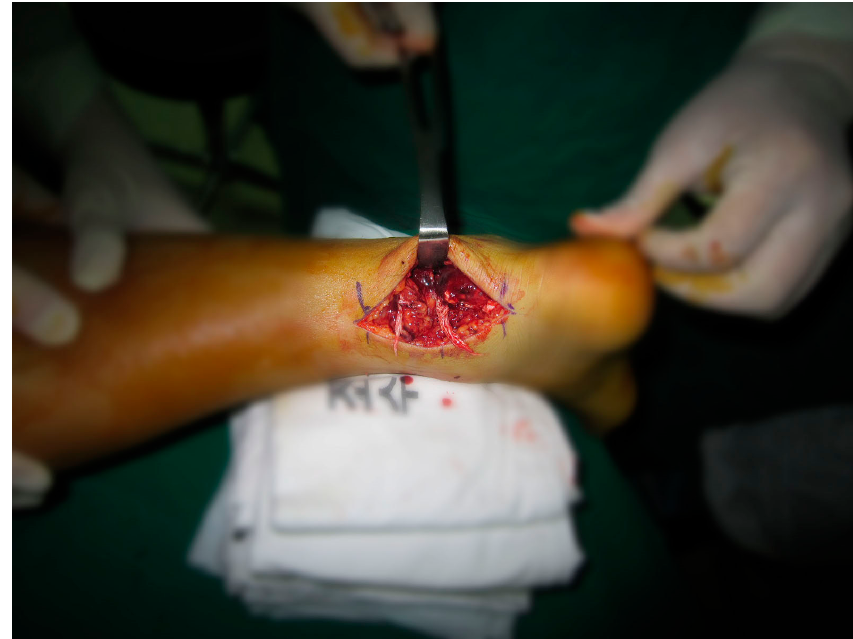
Figure 4. Intraoperative fi nding of Achilles tendon rupture in the right ankle.